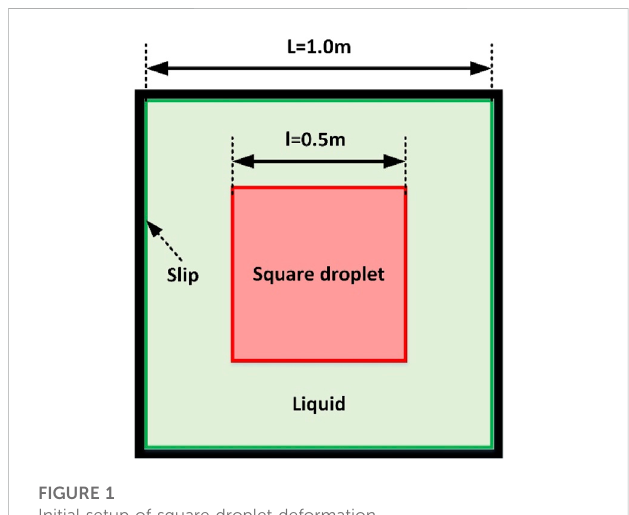
FIGURE 1 Initial setup of square droplet